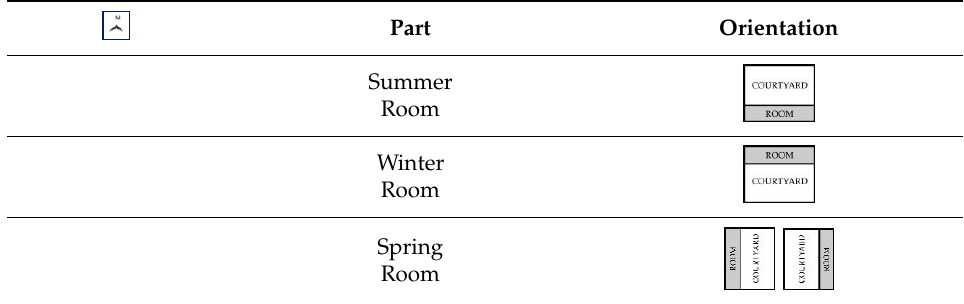
Table 3. The positioning of the seasonal spaces [41].